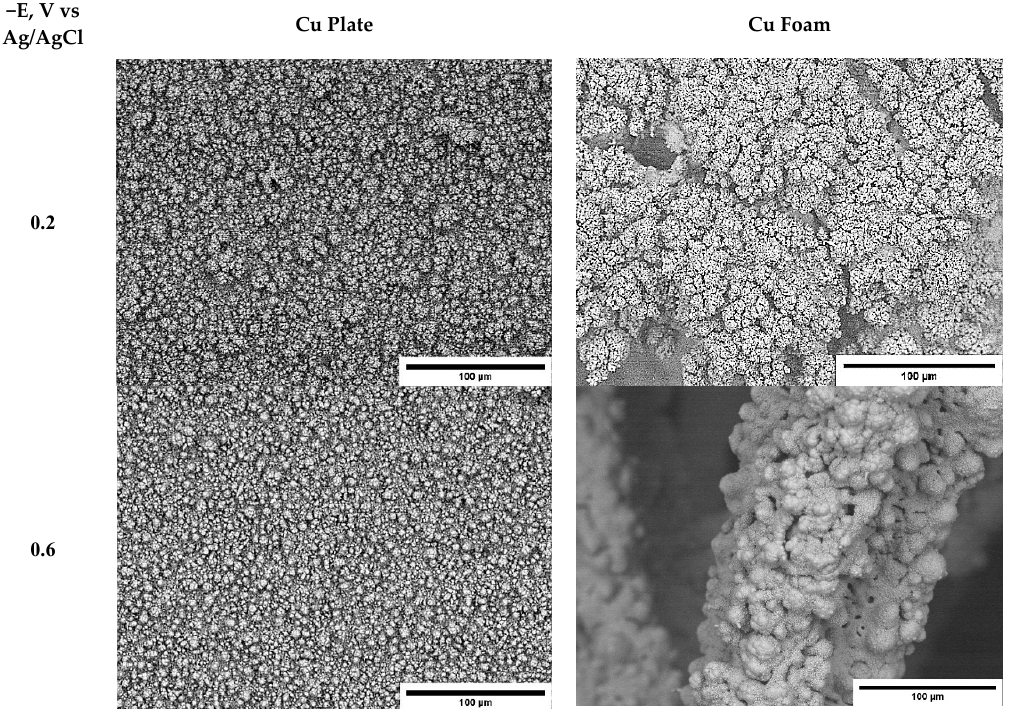
Figure 3. SEM images of potentiostatically electrodeposited Cu coatings at different cathodic potentials on flat and foam copper substrates after 30 C passed charge. The bath was 0.1 M CuSO 4 and 0.4 M Na 2 SO 4